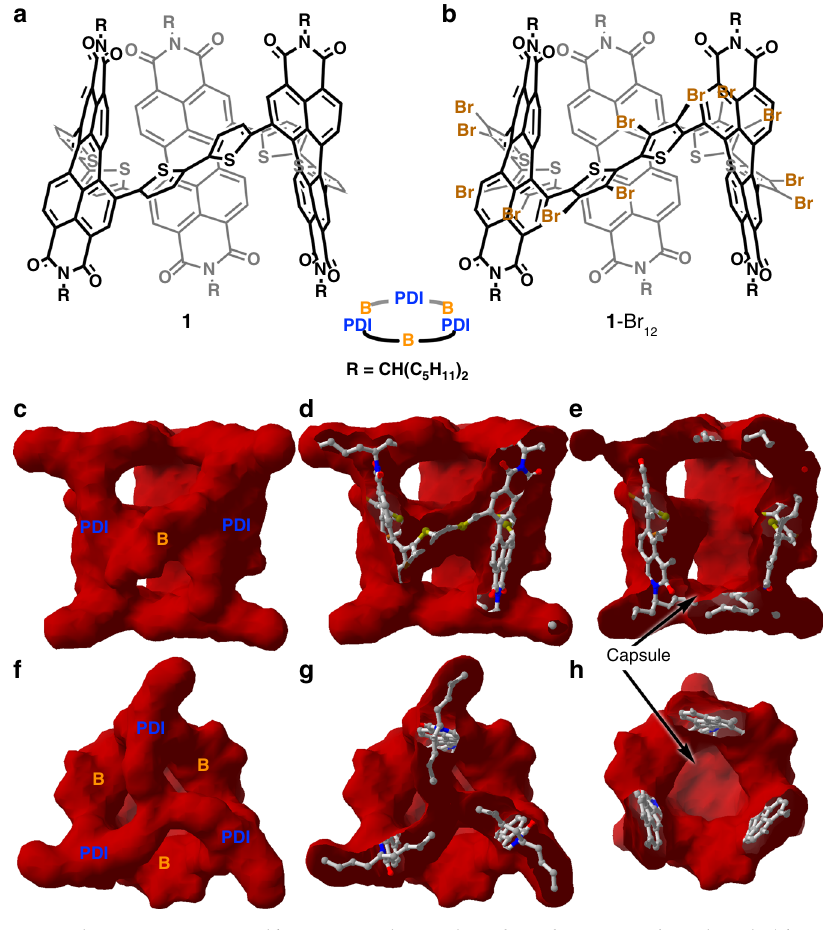
Fig. 1 Structures of cellular semiconductors. a Trimer 1 ; and b 1 -Br 12 . Van der Waals Surface of 1 -Br 12 seen from the side ( c ), and top ( f ). In the sequence c- e and f – h the molecule is trimmed down to expose its cavity or